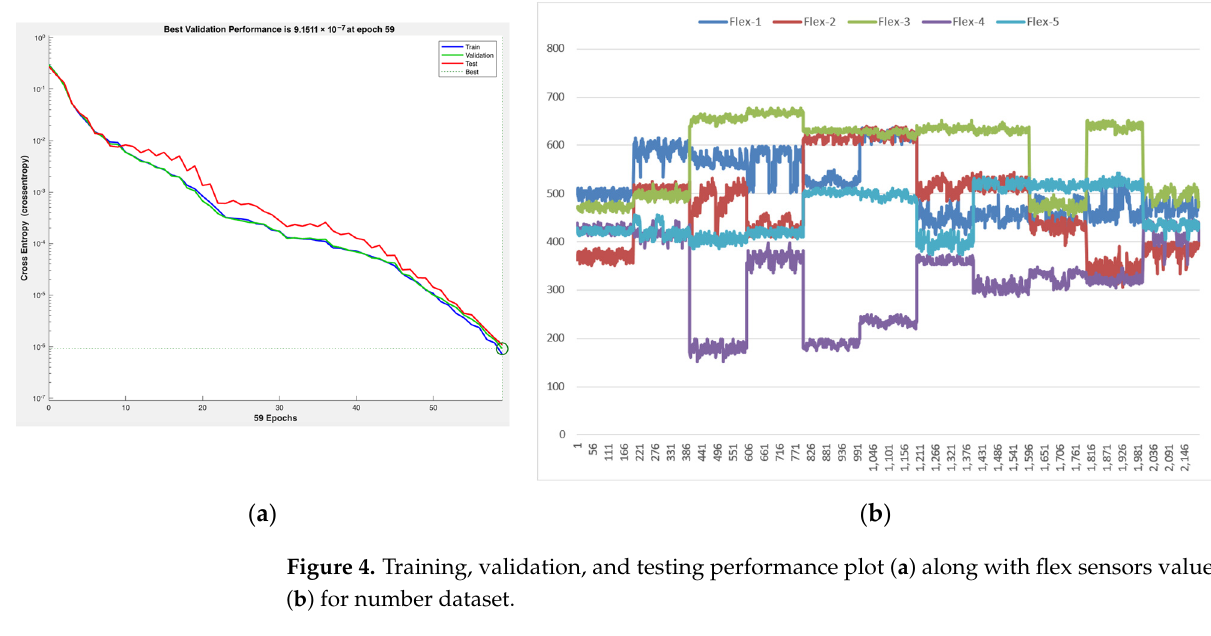
Figure 4. Training, validation, and testing performance plot ( a ) along with flex sensors values plot ( b ) for number